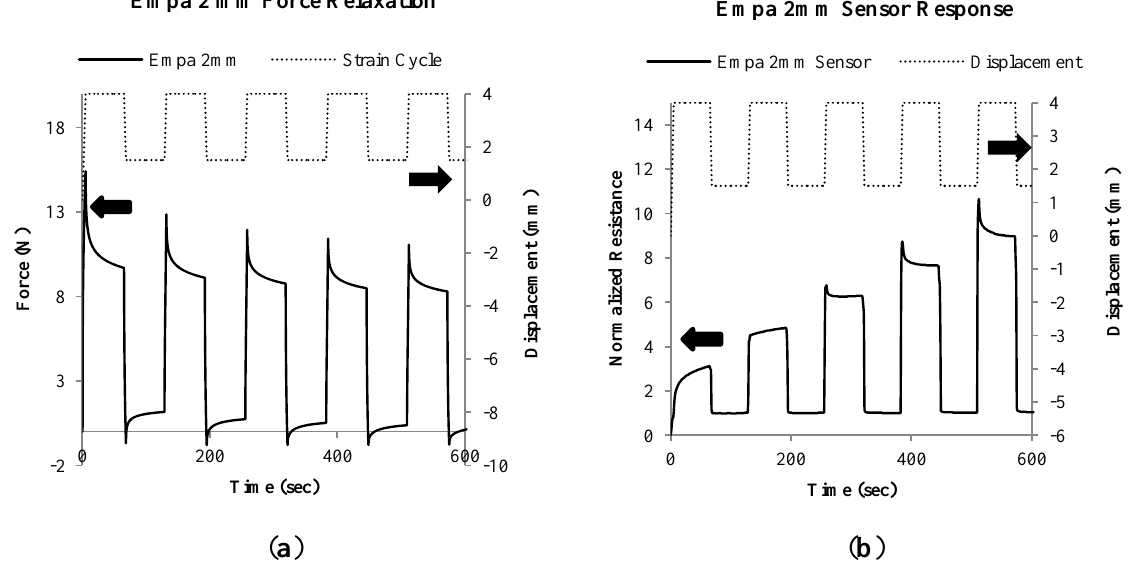
Table 4. Gauge factor ( k ) values for the different monofilaments at 30% and 15% strain